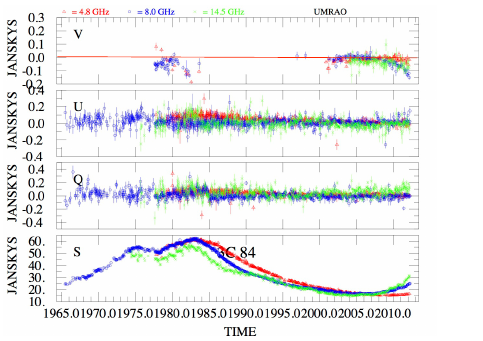
Figure 4. ( Left ): bottom to top: Long-term 2-week averaged Stokes parameters for the radio galaxy 3C 84 showing polarity changes at 4.8 GHz during the late-1970s through the early-1980s. Note the change in amplitude of V at 14.5 GHz associated with the commencement of new flaring circa 2008. ( Right ): total flux density, fractional linear polarization, EVPA and fractional circular polarization for 3C 279 illustrating polarity reversals which are most evident at 4.8